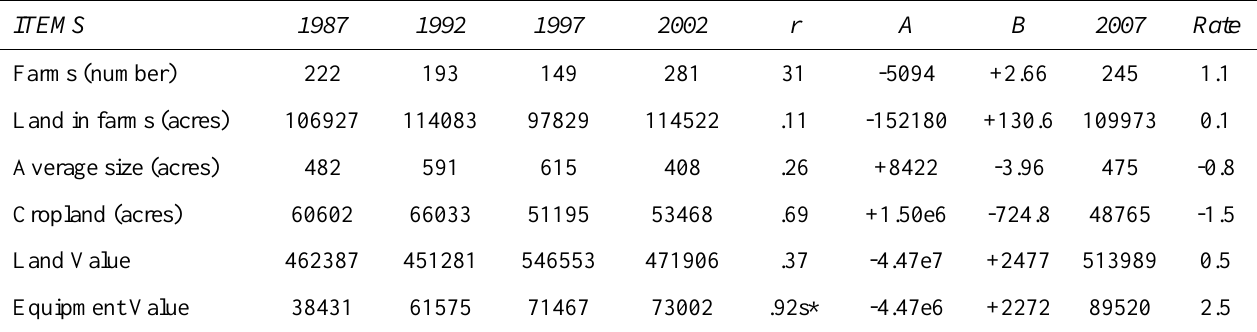
Table 2d: Warren County Regression Analysis